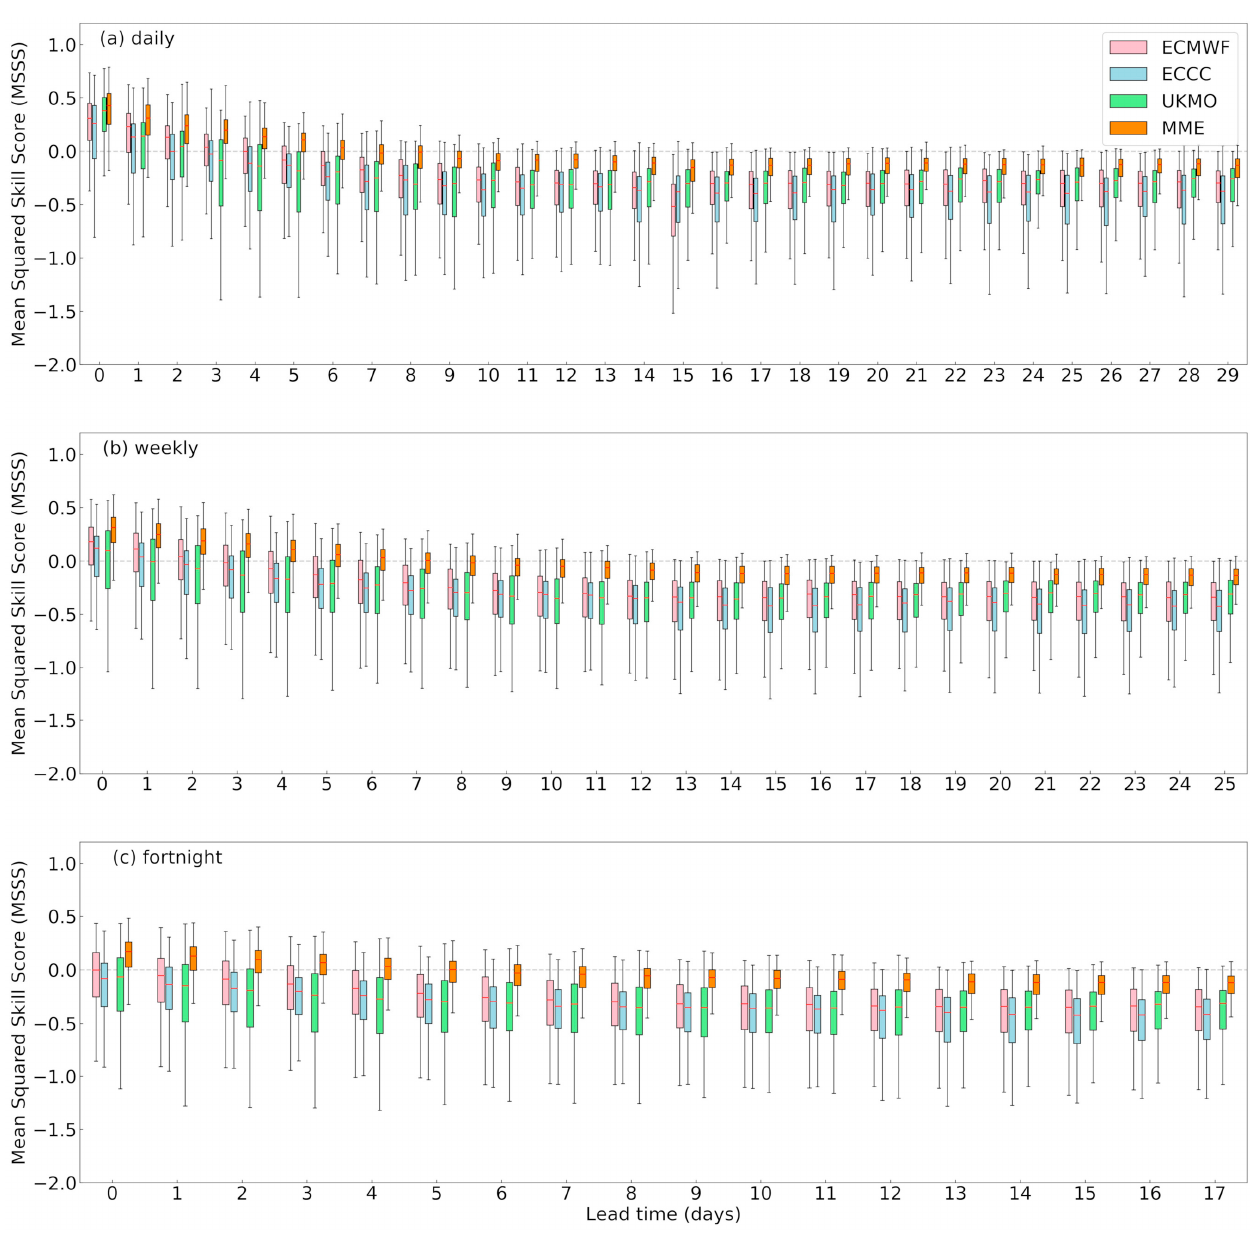
Figure 5. Boxplot diagrams of mean squared skill score of precipitation forecasts at different temporal scales (daily, weekly, and fortnight) of the ECMWF model, the ECCC model, the UKMO model, and the MME model during the boreal summer monsoon. The box spans the interquartile range (IQR) of mean squared skill scores, while the whiskers span the [0.1, 0.9] quantile range. The red line denotes the median value of mean squared skill scores.